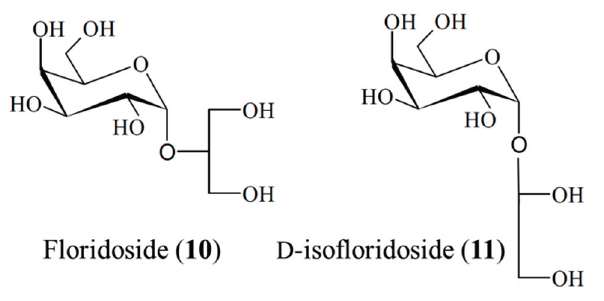
Figure 2. Floridoside ( 10 ) and D -isofloridoside ( 11 ), isolated from the marine alga Laurencia undulata